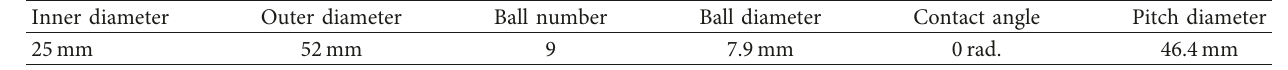
Table 2: Rolling element bearing parameters of 6205-2RS.